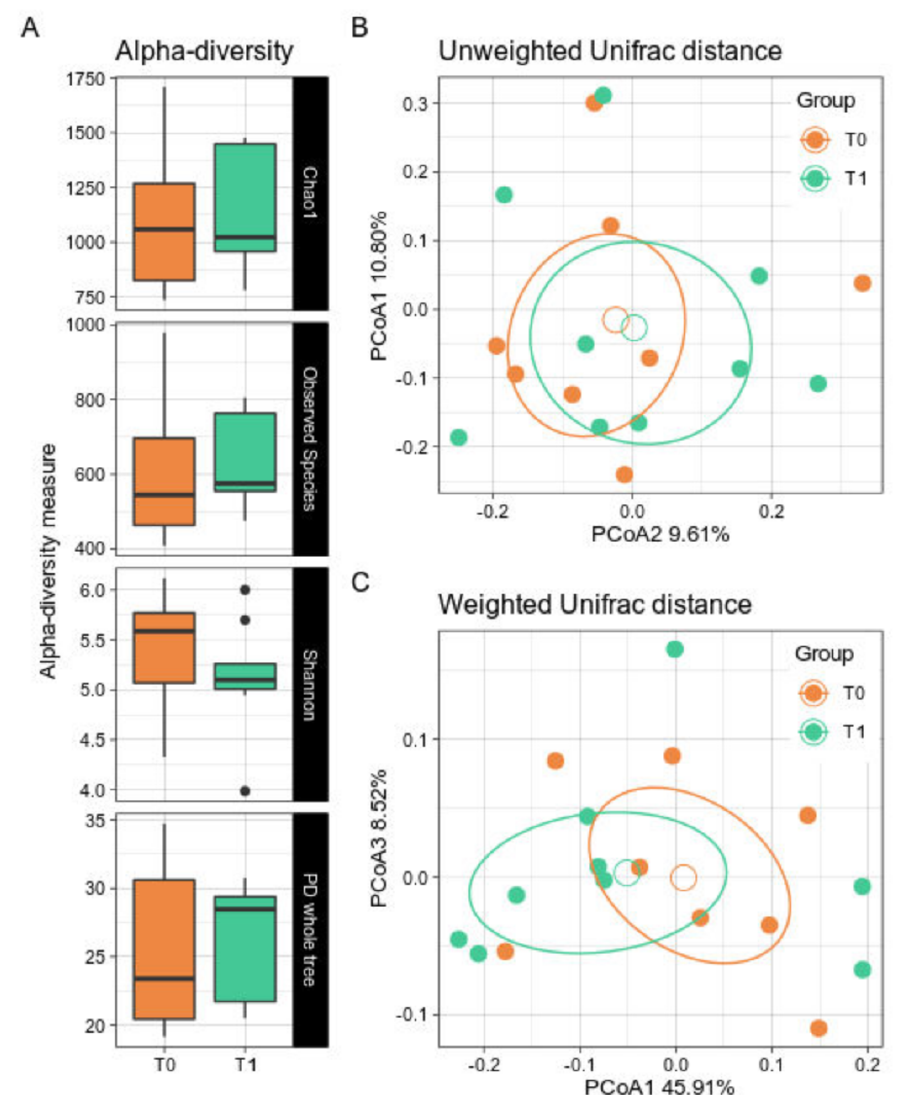
Figure 1. Alpha- and Beta-diversity between timepoints. PKU patients were sampled at baseline (T0) and after 6 months of GMP intake (T1). ( A ) Boxplots showing the metrics Chao1, Observed Species, Shannon index, and PD whole tree. Black dots represent outlier samples. ( B , C ). PCoA of the Unweighted and Weighted Unifrac distances with a boxplot of samples’ distribution for, respectively, the first and second coordinates and the first and third coordinates. T0 samples are depicted in orange; T1 in green. Solid dots represent single samples, empty circles represent the group average. For each group, confidence ellipse are reported. No statistically significant differences were observed among groups for both biodiversity